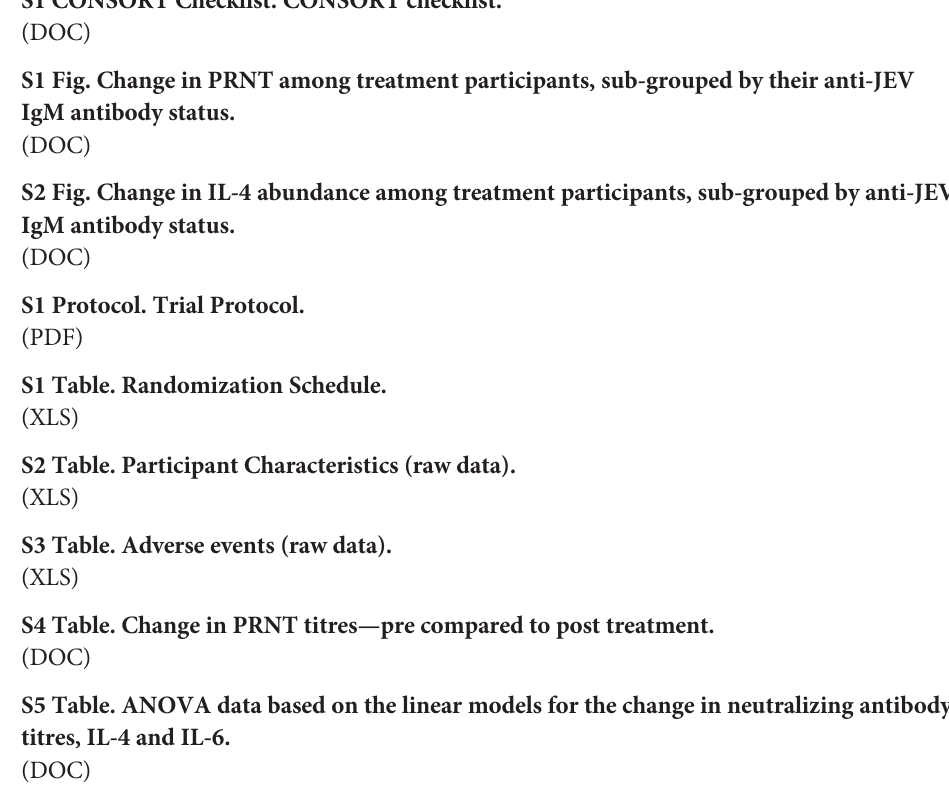
S4 Table. Change in PRNT titres — pre compared to post treatment. S5 Table. ANOVA data based on the linear models for the change in neutralizing antibody titres, IL-4 and IL-6. S6 Table. Change in cytokine abundance — pre compared to post treatment. S7 Table. Change in IL-4 abundance — pre compared to post treatment, sub-grouped by anti-JEV IgM antibody status. S8 Table. PRNT and cytokine levels (raw